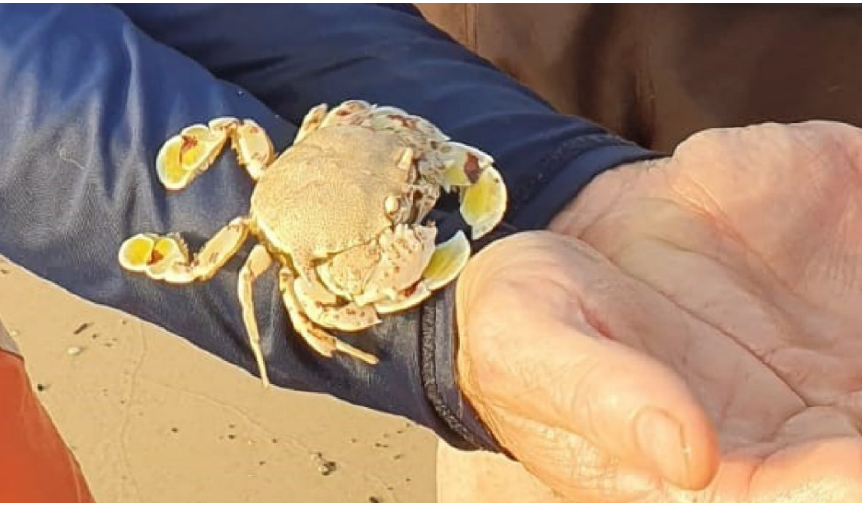
Figure 4. A specimen of the common moon crab Matuta victor at Ashdod beach, southern Israel, (photographed by Shani Tubul, 9 June 2021).